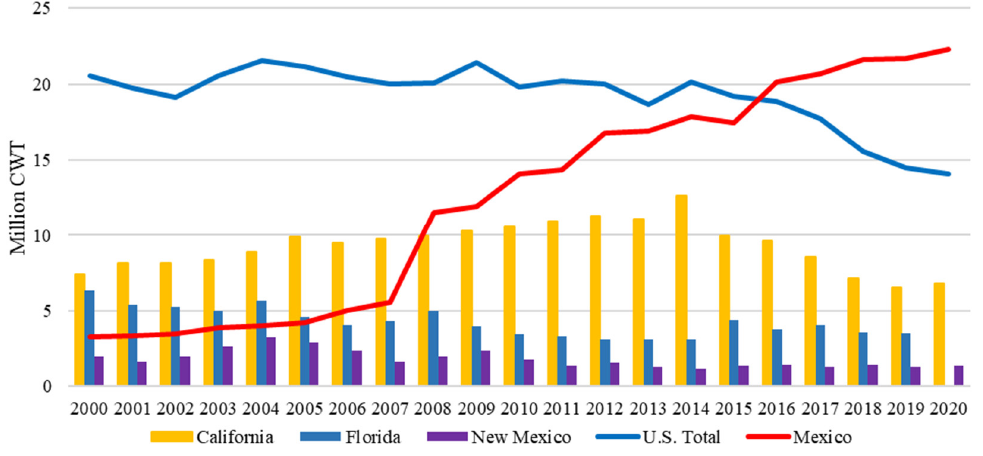
Figure 12. U.S. production and Mexican imports: peppers. Notes: The 2020 Florida production data is unavailable and not presented. Sources: USDA FAS [11]; USDA NASS [37].